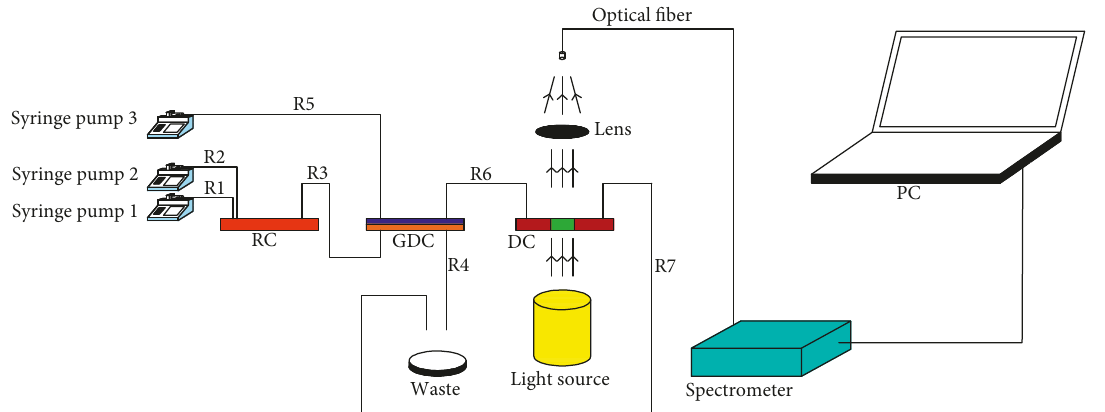
Figure 5: Schematic of the integrated